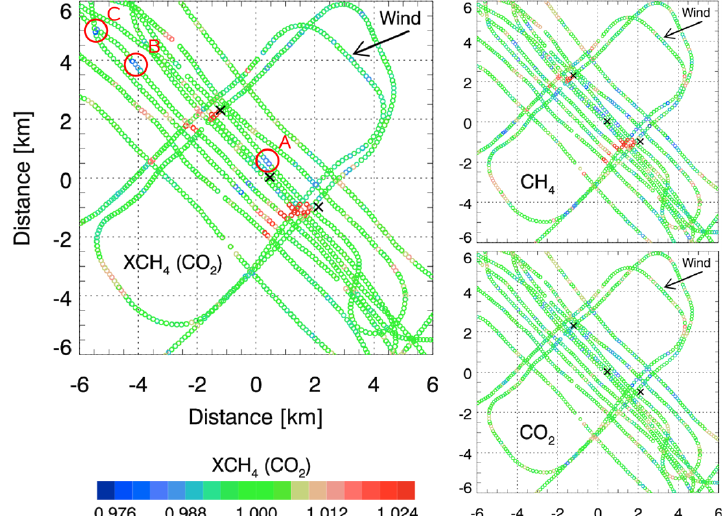
Fig. 3. Un-smoothed and not RMS-filtered MAMAP data. An altitude filter has been applied to obtain quantitatively meaningful results for X CH 4 (CO 2 ). Data have been normalised to regional background as observed during the flight. Upper and lower right show additionally the CH 4 and CO 2 single columns. Note that they do not represent dry air mole fractions and have a different scale than X CH 4 (CO 2 ). The encircled areas A, B and C denote areas with X CH 4 anomalies described in the main text.